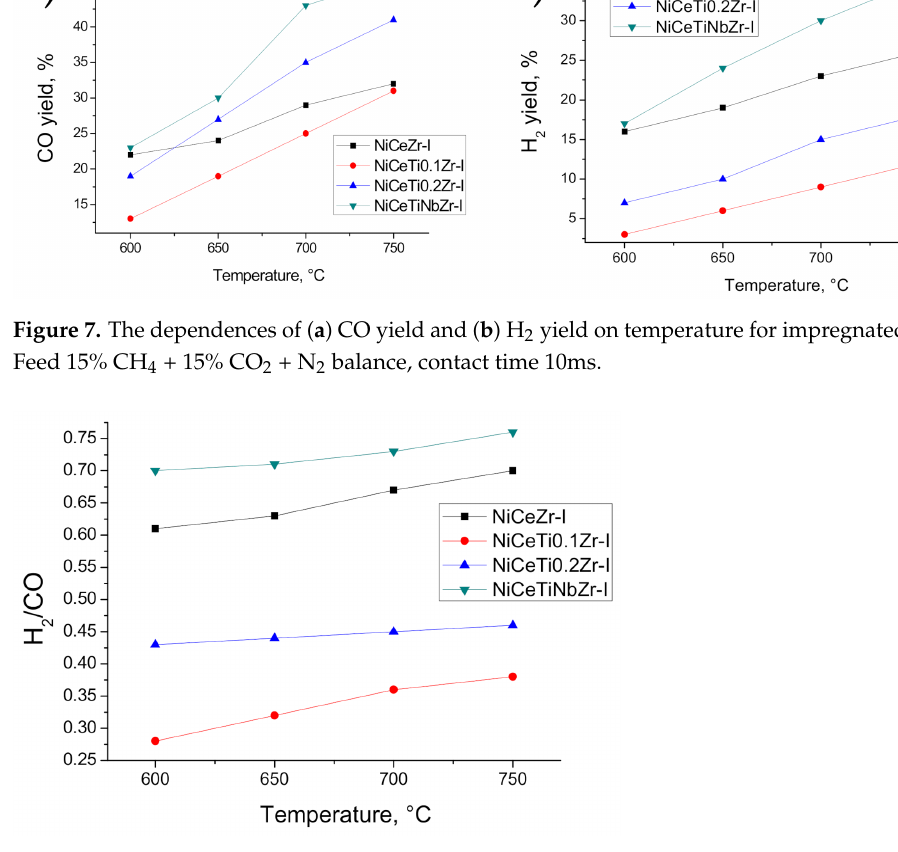
Figure 8. The dependences of H 2 /CO ratio on temperature for impregnated samples. Feed 15% CH 4 + 15% CO 2 + N 2 balance, contact time 10